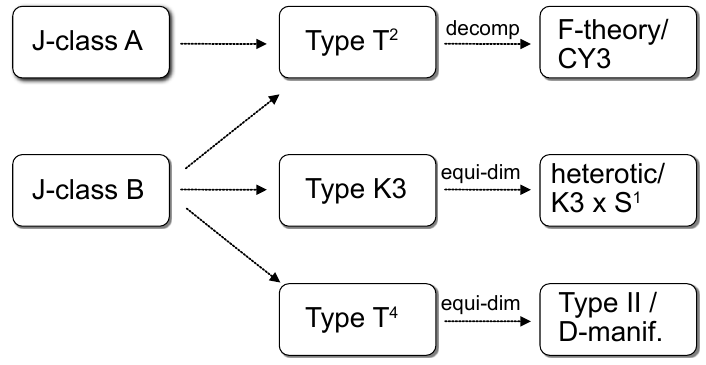
Figure 1 . Classification of large distance finite volume limits in classical Kähler moduli space, in terms of fibration types of Calabi-Yau three-folds, Y . Shown are also the corresponding dual stringy geometries that emerge from M-Theory on Y in the respective limits. Thus only limits of Type K3 and T 4 are equi-dimensional. As will be discussed later, for Type IIA strings on Y the situation is quite